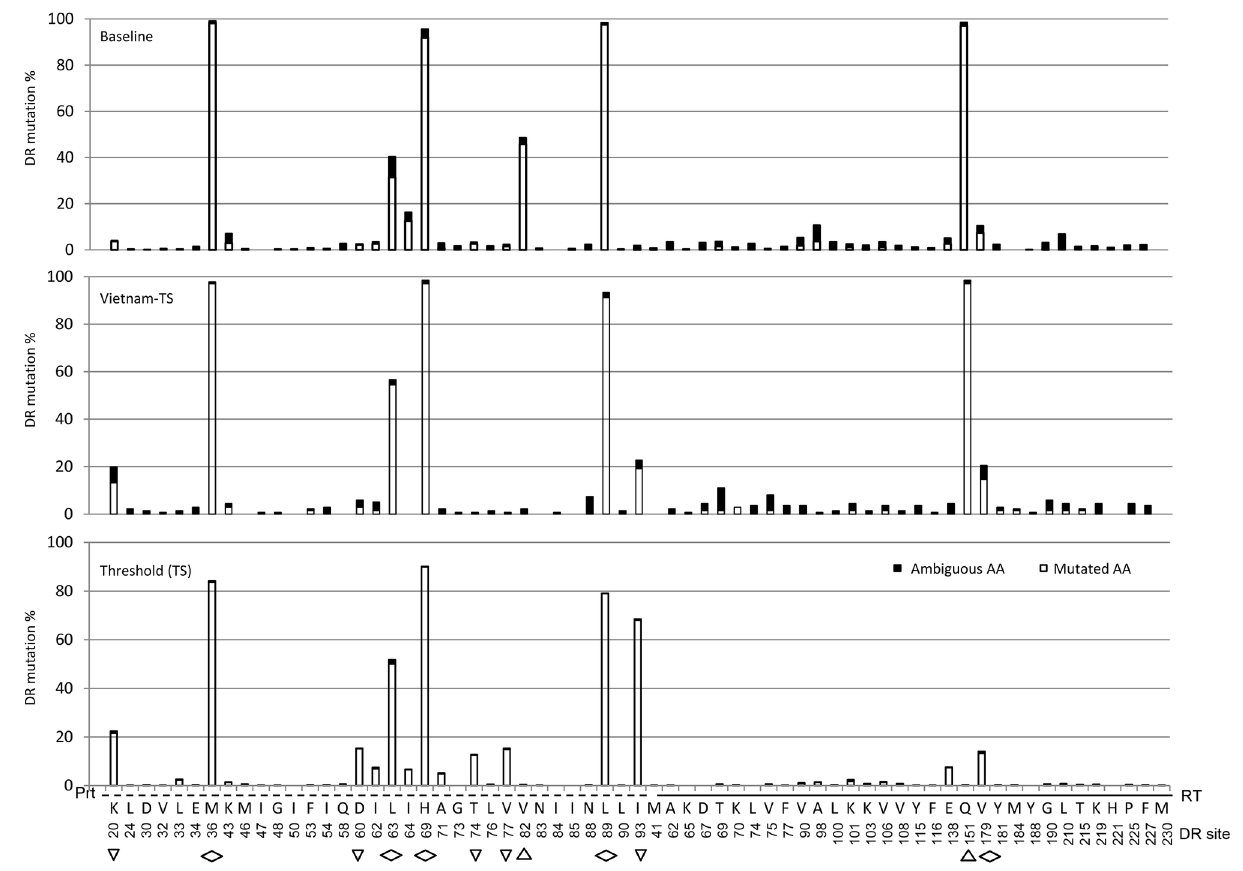
Figure 3. Proportional distribution of mutated and ambiguous mutated amino acids at HIVDR sites. The mutation score at each of the drug resistance sites [9] was proportionally calculated with the mutated and ambiguous mutated amino acids for all the sequences in the datasets. A mutated or ambiguous mutated amino acid was defined as an amino acid had mutated from a wild type to a pure non-synonymous mutation or an ambiguous mutation in the mixture allele. The scores were summed by 1 for a pure amino acid mutation and 0.5 for an ambiguous amino acid mutation, and then converted to percentages against the total number of wild-type amino acids at the site. The distribution of drug resistance mutation scores was plot by the dataset of Threshold (bottom panel), Vietnam (VN, central panel) and Baseline (top panel). The x -axis is the wild-type amino acids at drug resistance sites; the y - axis is the drug resistance mutation score (%). The sites with obvious score changes across the 3 datasets from bottom to top panel were labeled by up-triangle (increased), rhombus (remained), and down- triangle (decreased). Amino acids of protease gene (Prt) were top-dash lined, and of reverse transcriptase gene (RT) were top-solid